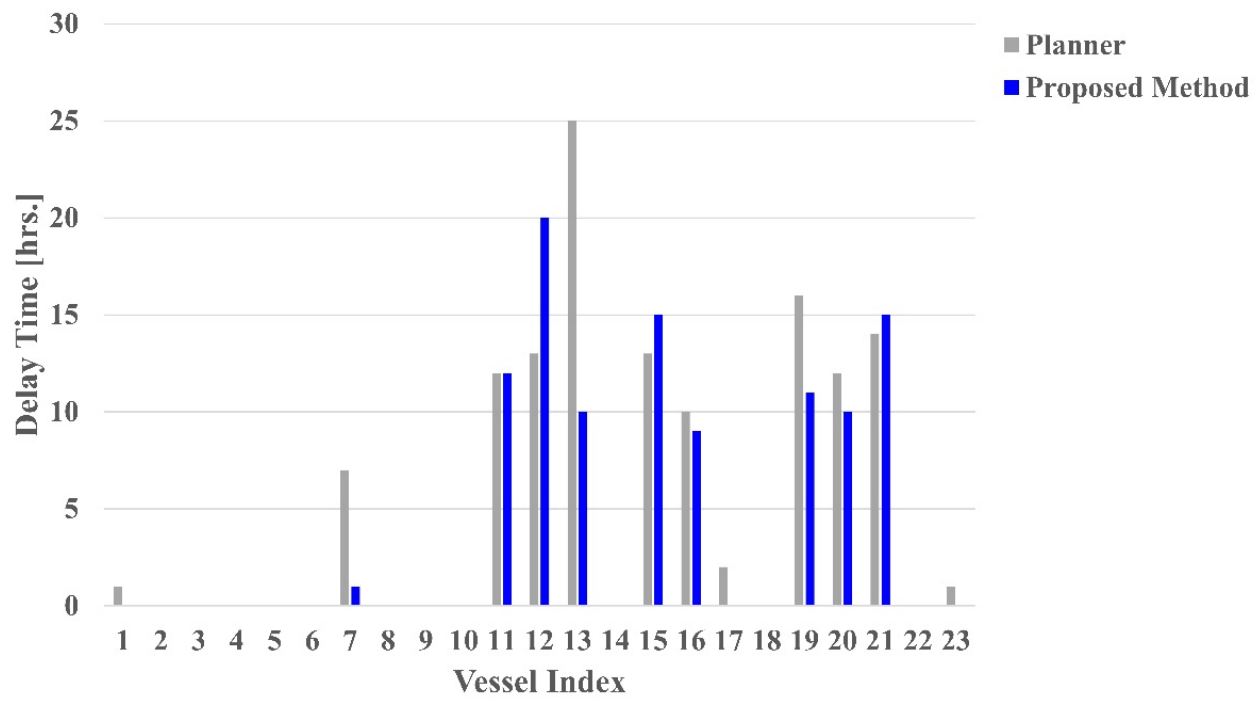
Figure 10. Departure delay time by vessel in Scenario 3.